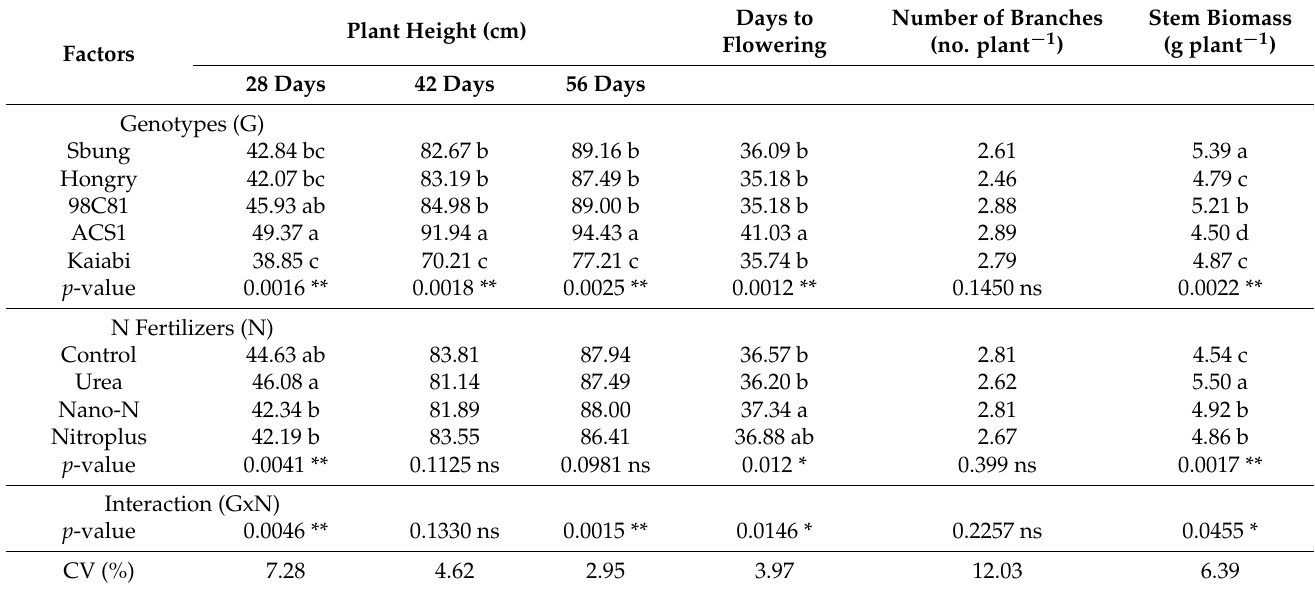
Table 1. Plant height at different days after growing, days to flowering, number of branches, and stem biomass, as affected by genotypes and N fertilizer